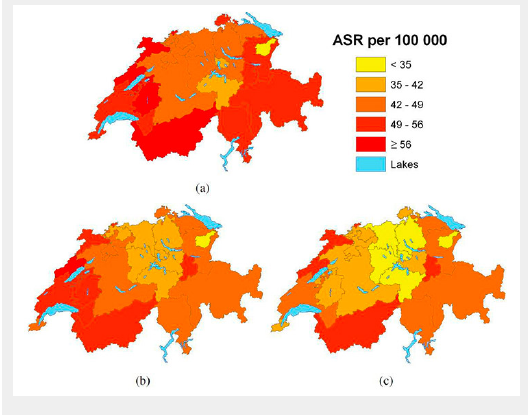
Age-standardised tobacco-related cancer mortality rates (per 100,000) for males age ≥50 years, (a) observed during 2004–2008